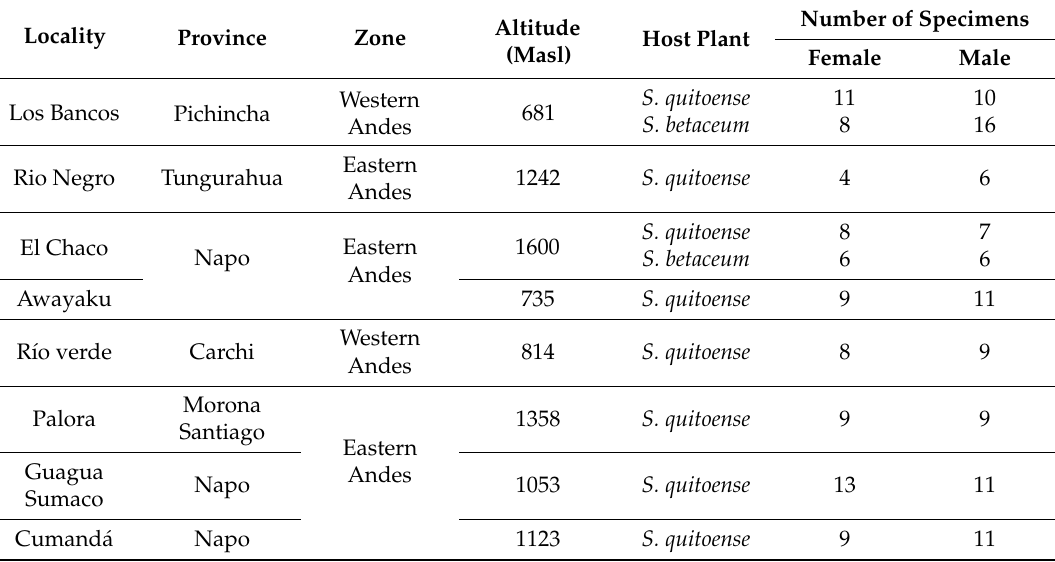
Table 1. Sampling areas of the study in Ecuador, South